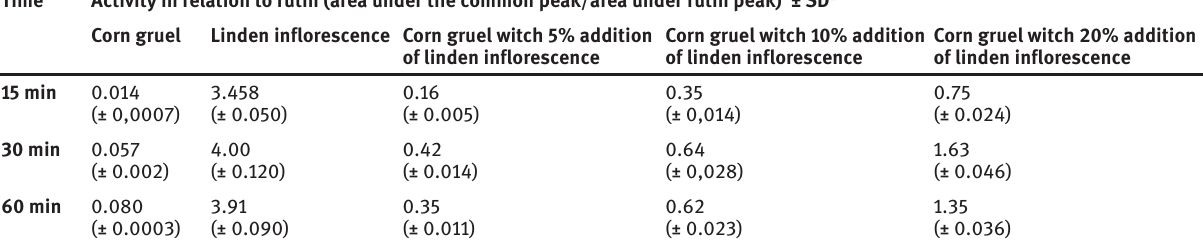
Table 1: Activity of investigated samples in relation to rutin’s activity. Concentration of rutin – 0.5 mg mL -1 . Time Activity in relation to rutin (area under the common peak/area under rutin peak) ± SD a Corn gruel